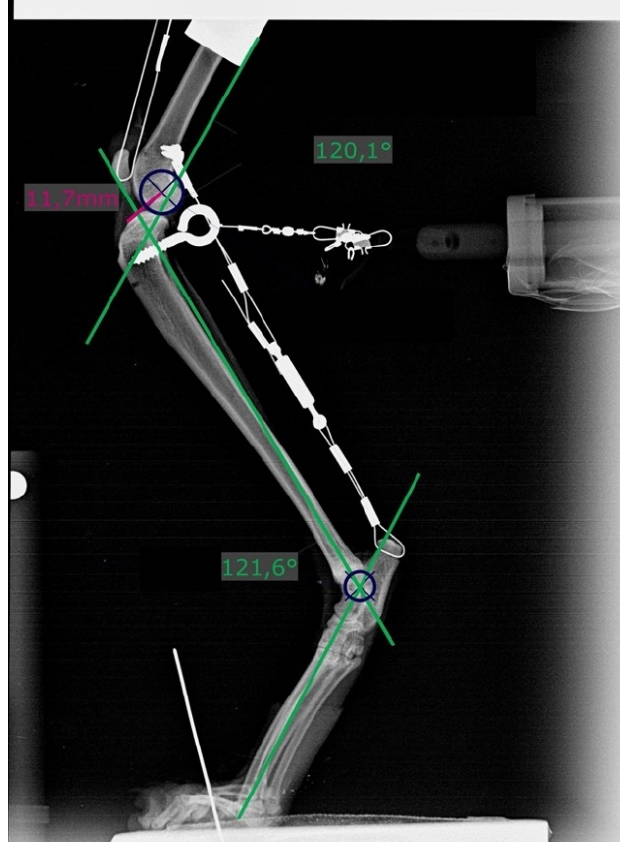
Figure 3. Radiograph showing measurement of stifle and tarsal joint angles (green lines) on the left hindlimb with a transected cranial cruciate ligament and loaded with 20% body mass. Dark blue circles ( r = 6 mm) are superimposed over the caudal aspect of the femoral condyles. Distances were measured from its center to the most cranial point of the tibial plateau (pink line).